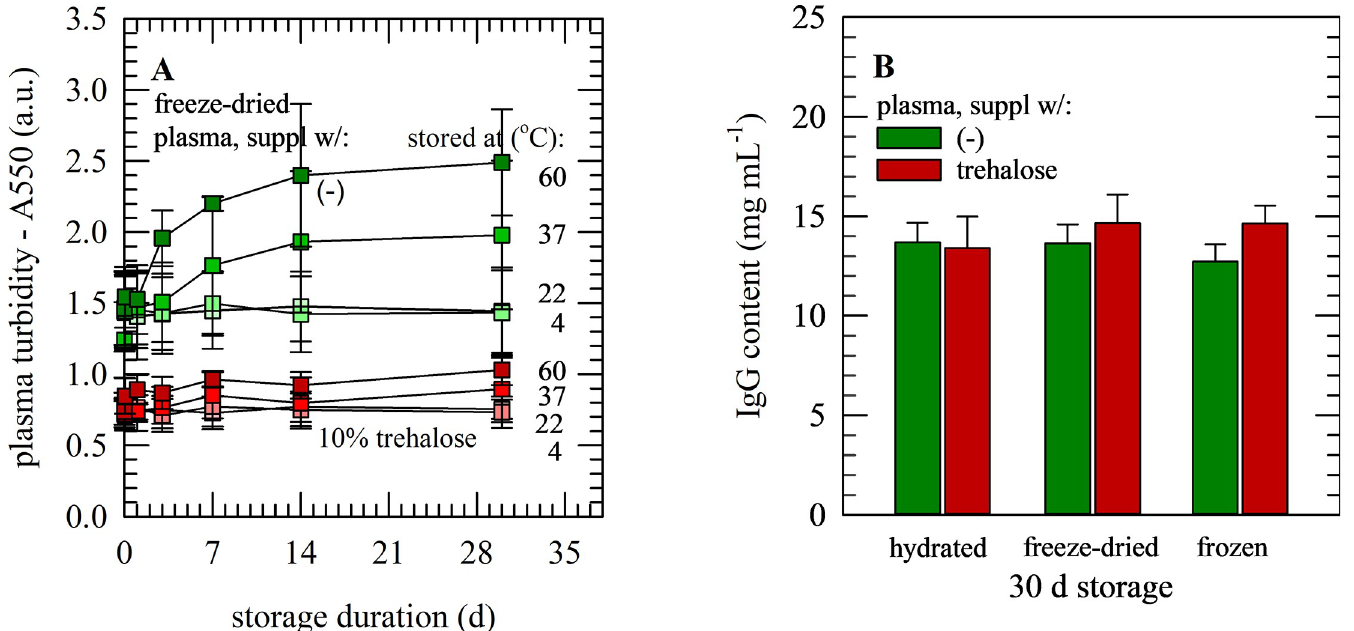
Fig 4. Storage stability of freeze-dried plasma samples. Turbidity/protein aggregation characteristics of freeze-dried plasma samples stored for up to 1 month at temperatures ranging from 4 − 60˚C (A), as well as plasma IgG contents after storage under different conditions (B). Freeze-drying was done without supplements (green) as well as with supplementation of 10% trehalose (red). Turbidity was assayed directly after rehydration, as the absorbance at 550 nm (A). IgG contents were determined for plasma samples after 30 d storage; for hydrated sample and freeze-dried samples stored at 22˚C, as well as frozen samples stored at − 80˚C. Mean values ± standard deviations are presented from replicate measurements performed using plasma from three different